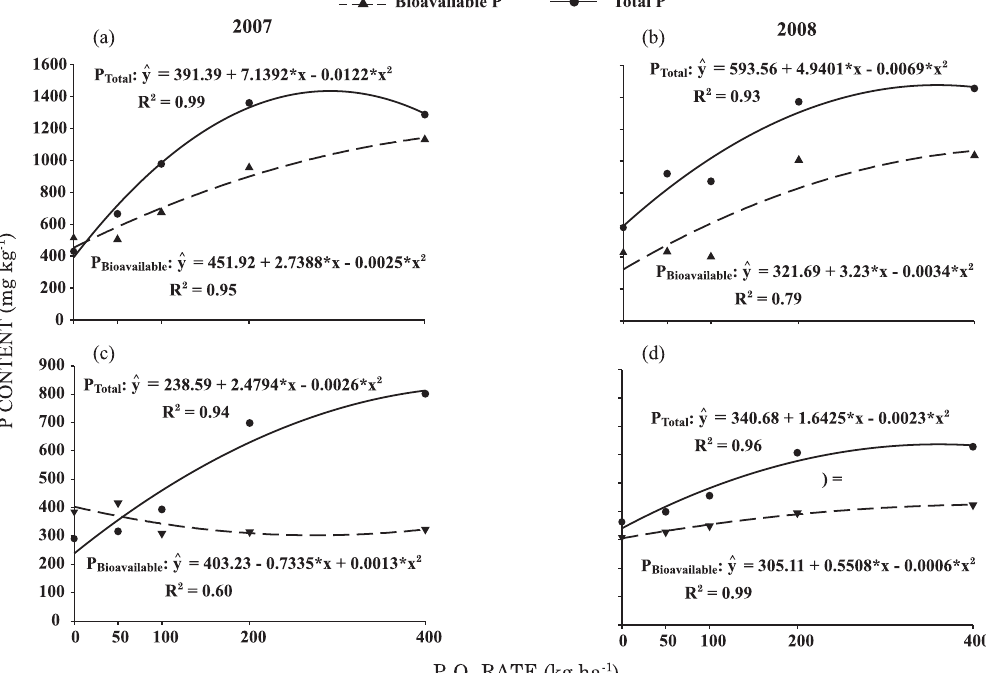
Figure 4. Contents of bioavailable phosphorus fractions (Hedley) and total recovered phosphorus in soil samples collected in two years (a and b = depth of 0–10 cm, c and c = depth of 10–20 cm), in function of annual phosphorus applications. * Significant by t test at 5